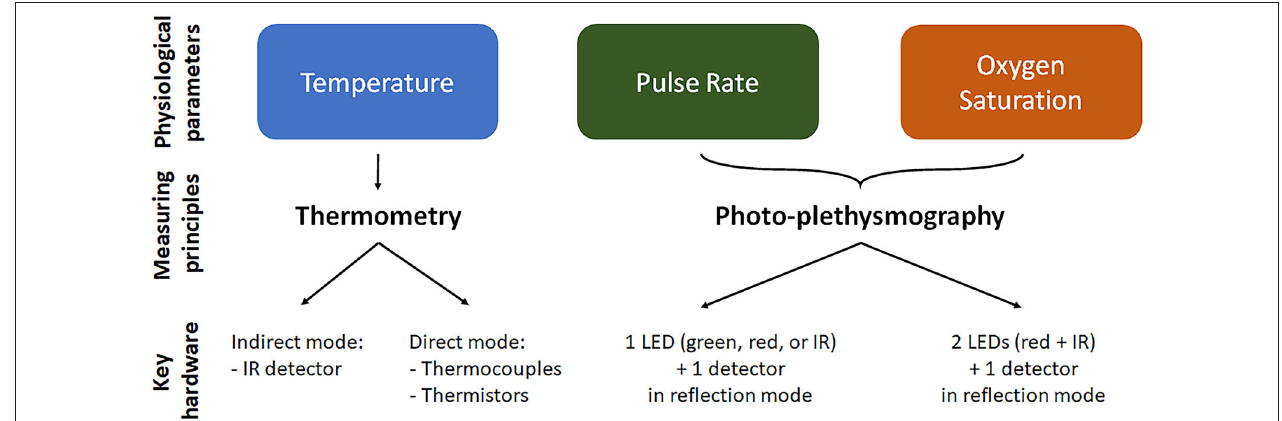
FIGURE 2 | Physiological parameter measurement in the ear canal. For each of the parameter we reported the mainly used measurement technique and the key elements/working configuration of the measuring device. Temperature is measured by thermometry approach using indirect infrared (IR) thermometers or direct thermopile or thermocouple thermometers. Oxygen saturation and pulse rate are measured using photo-plethysmography, where light is emitted at two or one wavelength, respectively, and the reflected light is detected and analyzed. LED, light emitting